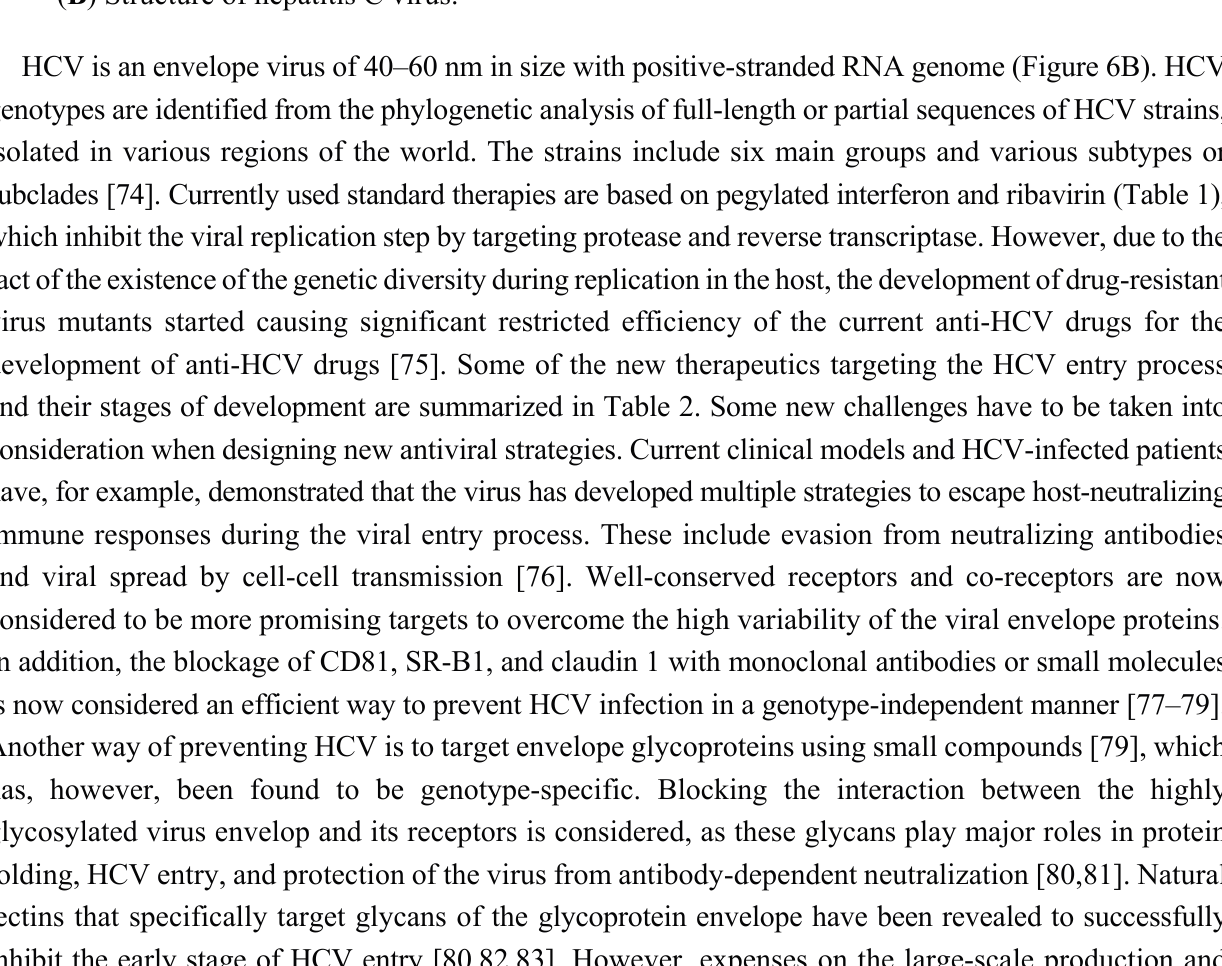
Figure 6. ( A ) Schematic illustration of natural history of HCV infection. HCV infection starts with acute infection and chronic hepatitis can lead to cirrhosis and mortality [74]; ( B ) Structure of hepatitis C